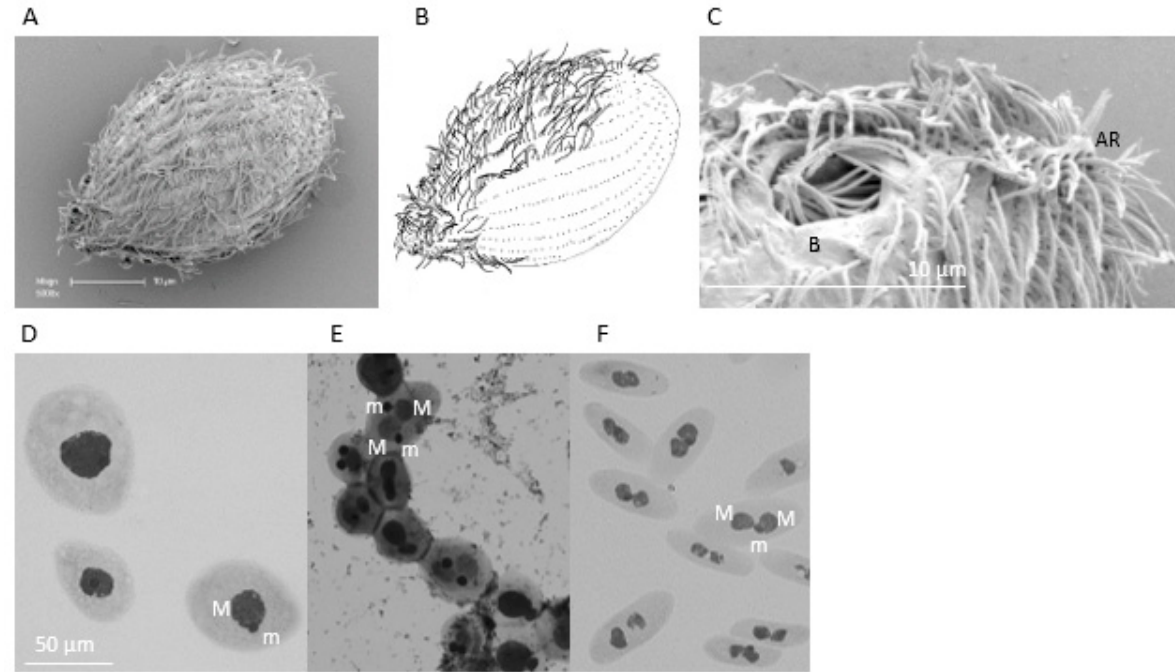
Figure 1. ( A ) Scanning electron micrograph and ( B ) line drawing of T. rostrata TRAUS showing a trophont with 28 rows of cilia and a tapered rostrum; ( C ) scanning electron micrograph of the buccal opening (B) and anterior rostrum (AR); Giemsa stained ( D ) trophonts, ( E ) cysts and ( F ) theronts showing macronuclei (M) and micronuclei (m).